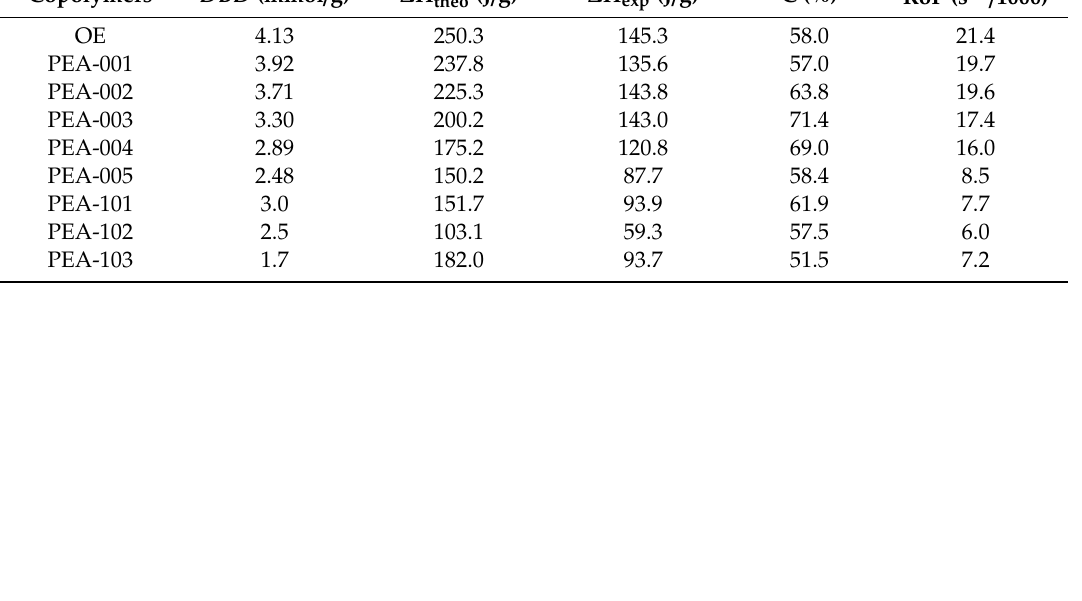
Table 3. Overview over double bond density, enthalpy, rate of polymerization, and conversion.